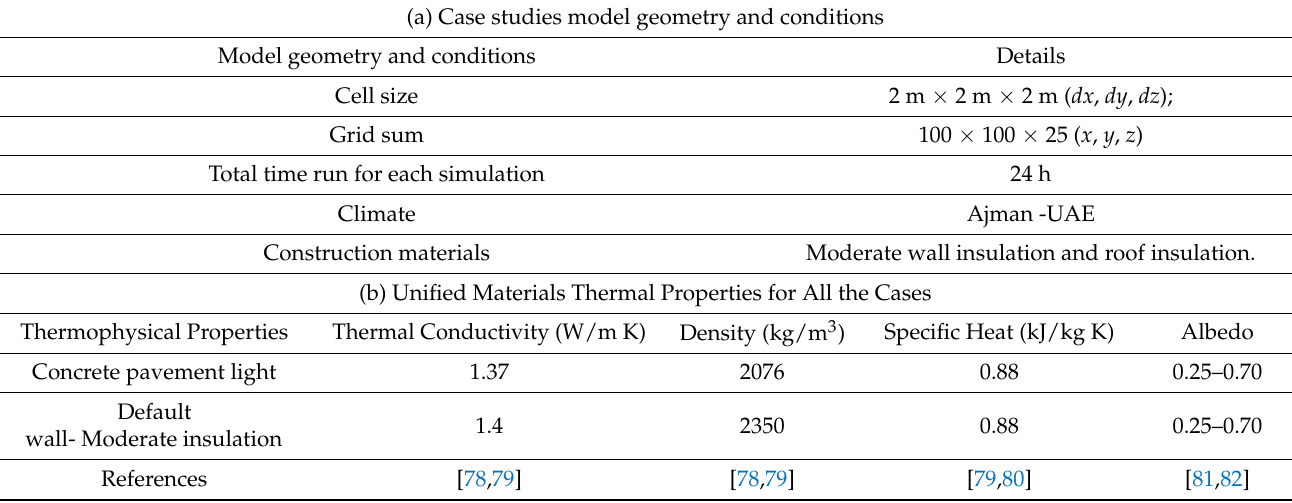
Table 5. Case study model geometry and